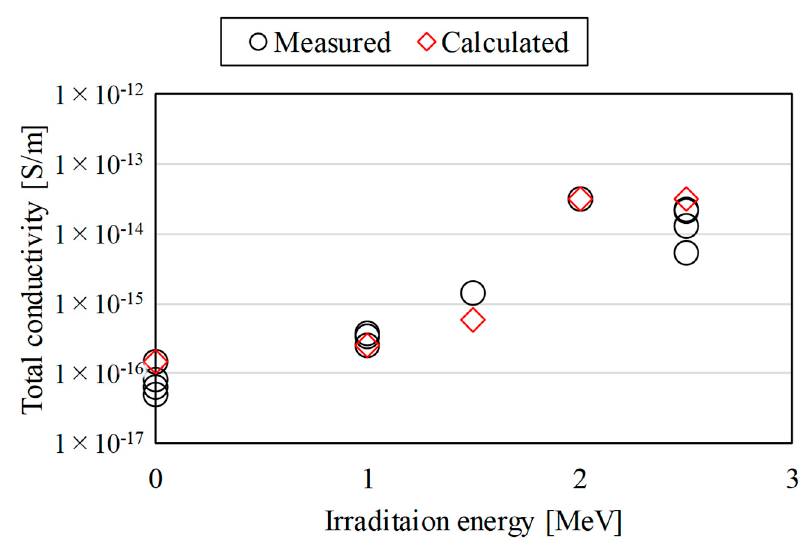
Figure 7. Calculated results of the total conductivity of the proton irradiated samples at 180 min after the start of the measurements. The irradiation energy dependence of conductivity after 1 day of proton irradiation.